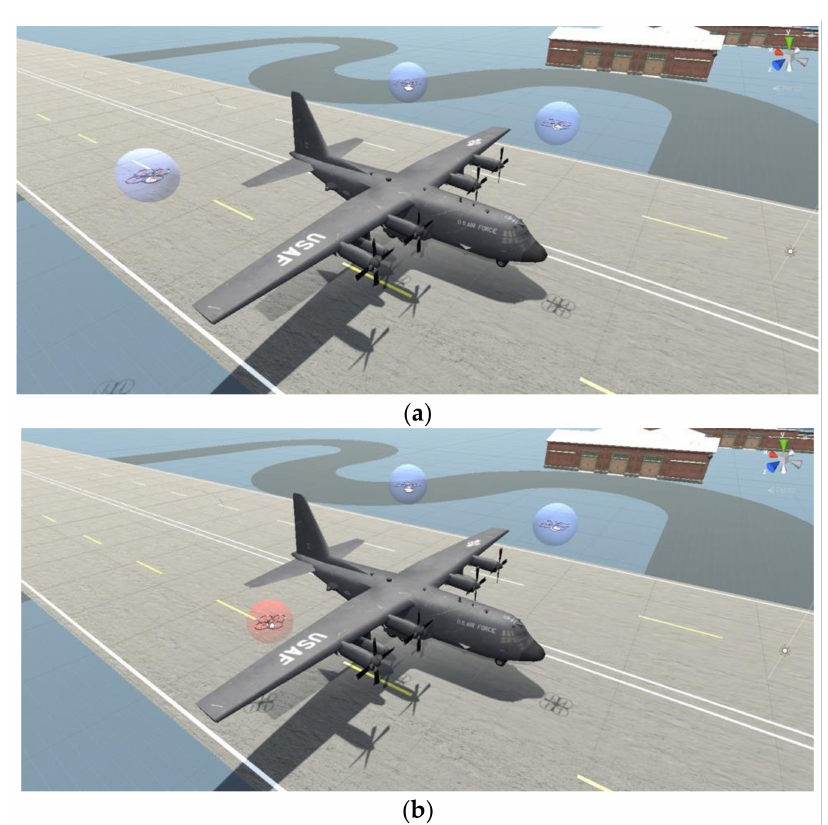
Figure 9. ( a ) All UAVs in “safe states”, and ( b ) one UAV in “unsafe